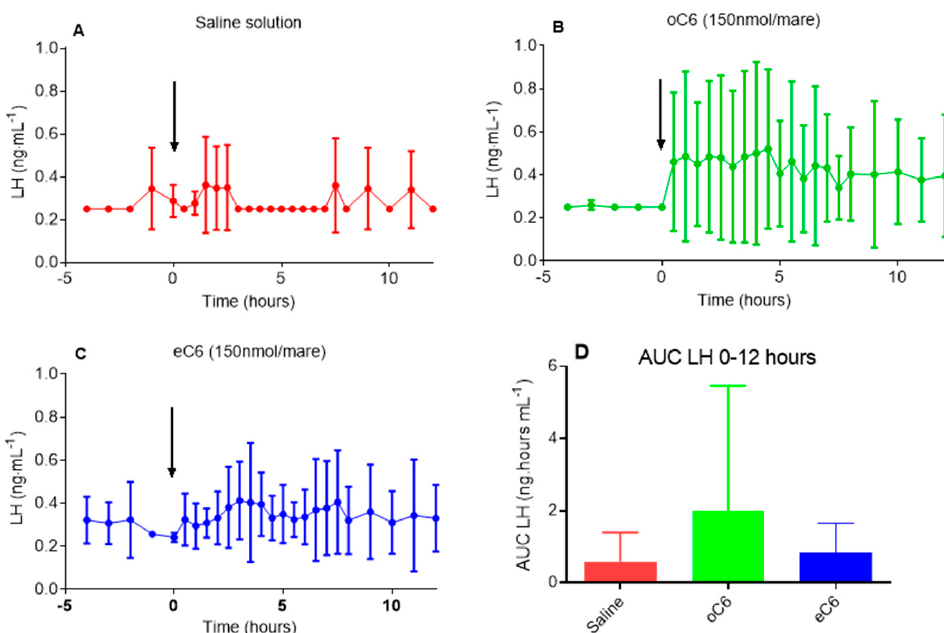
Figure 4. Effect of oC6 and eC6 on LH secretion during the non-breeding season. During the non- breeding season, an iv injection of 150 nmol/mare of either oC6, eC6 or saline solution was delivered at time zero (arrow). Serial blood samples were taken from 4 h before to 12 h after injection and assessed for LH content by RIA. The time course of LH plasma concentration showed that oC6 ( B ) increased LH by about 1.9-fold compared to basal, but the difference was not significant (F = 1.1, p = 0.36), whereas for eC6 ( C ), F = 0.84, p = 0.68) and saline solution ( A ); F = 0.77, p = 0.76) no increase was observed after treatment. The analysis of the area under the curve (AUC) showed that the total amount of LH released after oC6 treatment is about 3 times that of basal and twice that of eC6, but due to the high inter-individual variability this was not statistically significant (F = 0.77, p = 0.48) ( D ). Data are expressed as mean ± SD. Statistical analysis was performed by using ANOVA on repeated measures ( A – C ) or Kruskal-Wallis test ( D